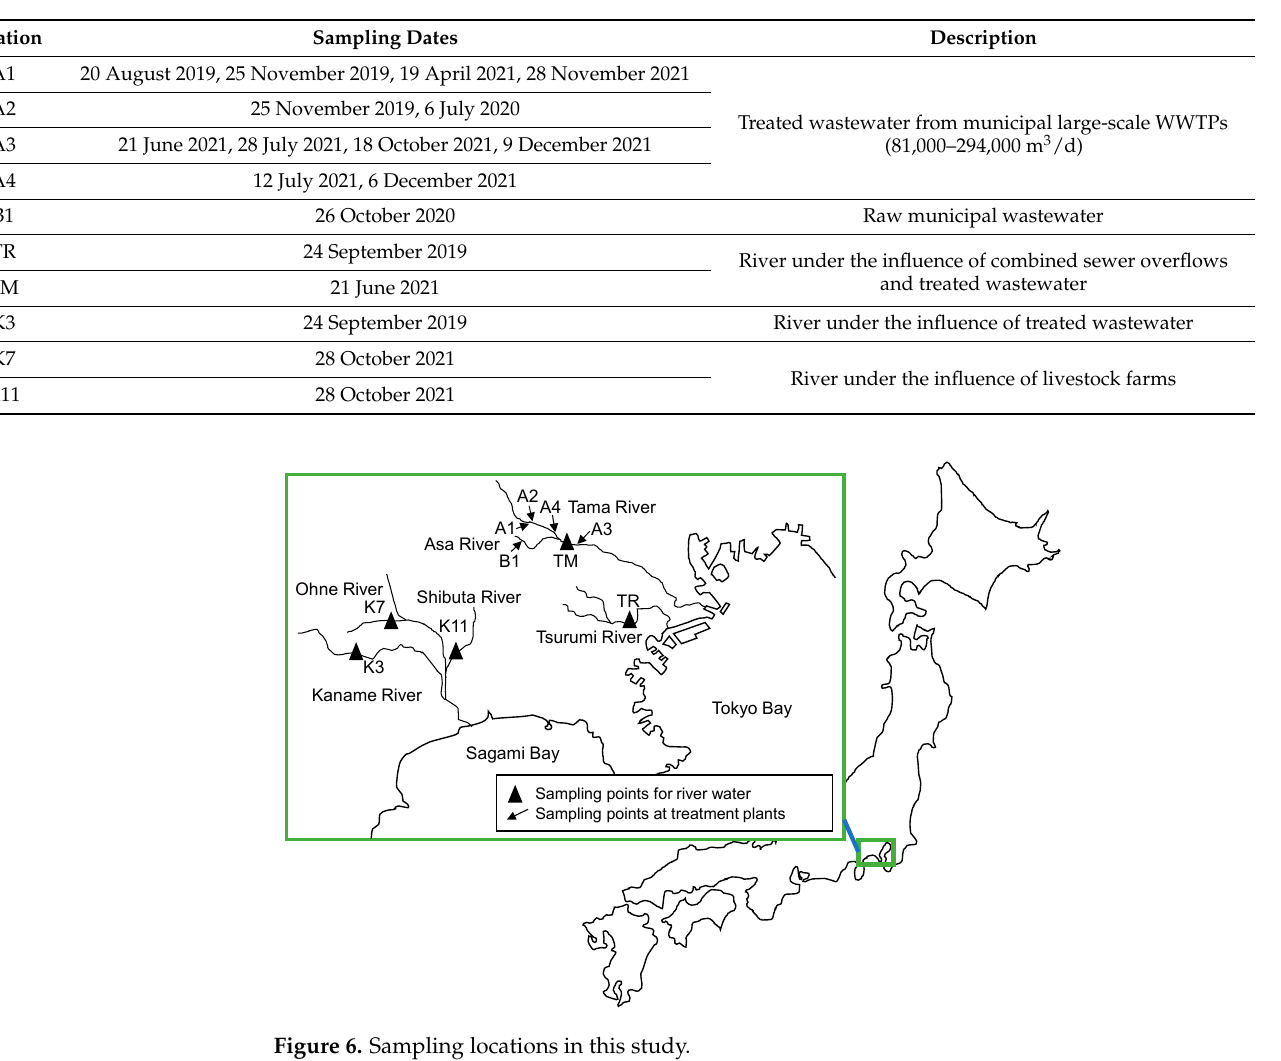
Figure 6. Sampling locations in this study.